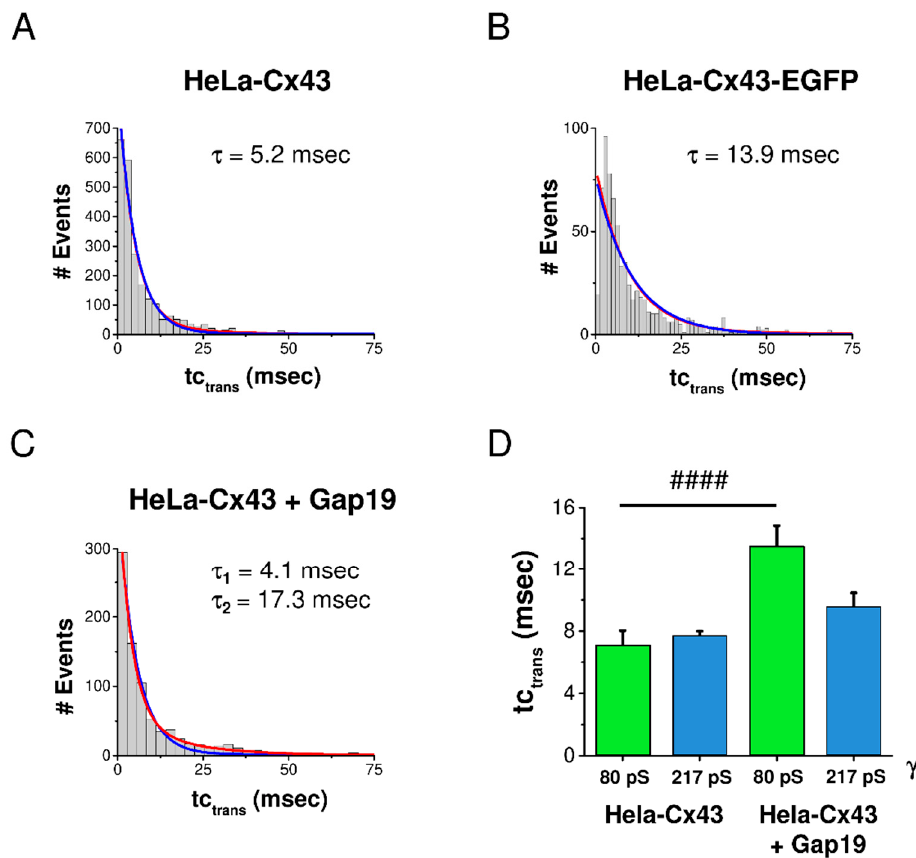
Figure 5. Distribution of transition kinetics and effect of CT-tagged EGFP and CT-interacting Gap19 peptide. Mono- and biexponential fits are displayed in blue and red, respectively. ( A ) In HeLa-Cx43 cells, tc trans was distributed along a monoexponentially decreasing function characterized by a τ of 5.2 msec ( N = 4; N = 15; n = 132). ( B ) For HeLa-Cx43-EGFP, τ was more than twice as large compared to HeLa-Cx43 ( N = 3; N = 6; n = 39). ( C ) HeLa-Cx43 treated with Gap19 showed a second longer τ compared to the control ( N = 3; N = 8; n = 50). ( D ) Selective analysis of tc trans for transitions in the subconductance and main state demonstrated that Gap19 significantly slowed down transitions to the subconductance state while leaving main state transitions unaffected (Mann–Whitney U test, #### p ≤ 0.0001). Number of events: HeLa-Cx43 80 pS (129 events), HeLa-Cx43 217 pS (1656 events), HeLa-